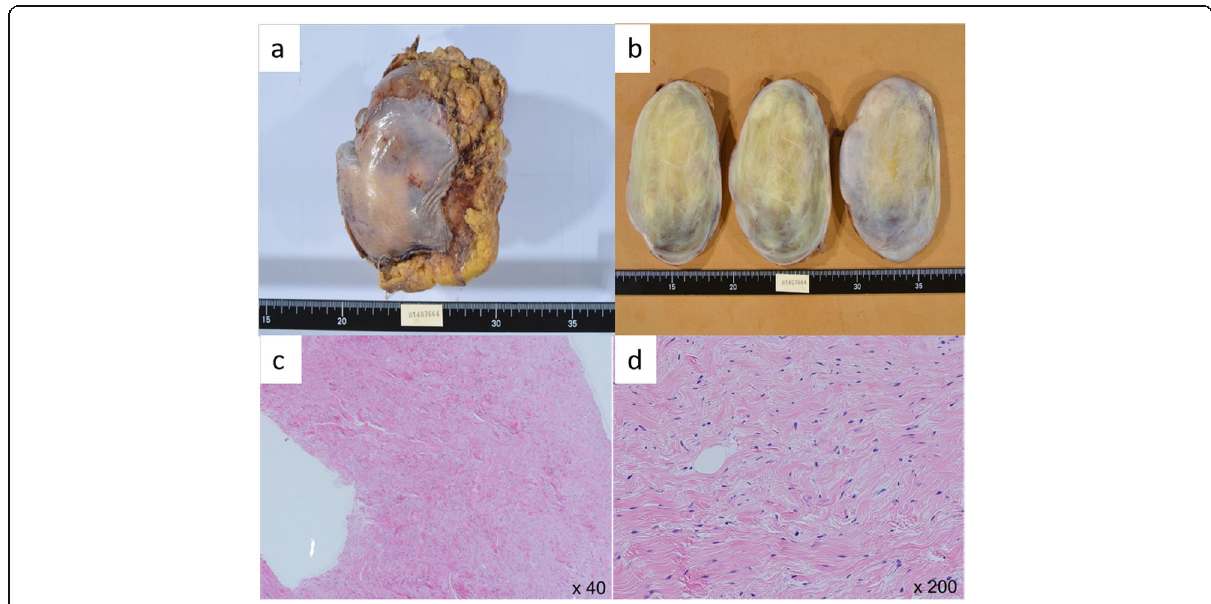
Fig. 2 The tumor measures 11.9 × 11.2 × 8.1 cm and is well-demarcated, elastic, hard, and yellowish white with a film ( a , b ). Operative rapid pathological findings: the tumor is composed of a rich collagenous fiber and pattern-less spindle cells ( c , d